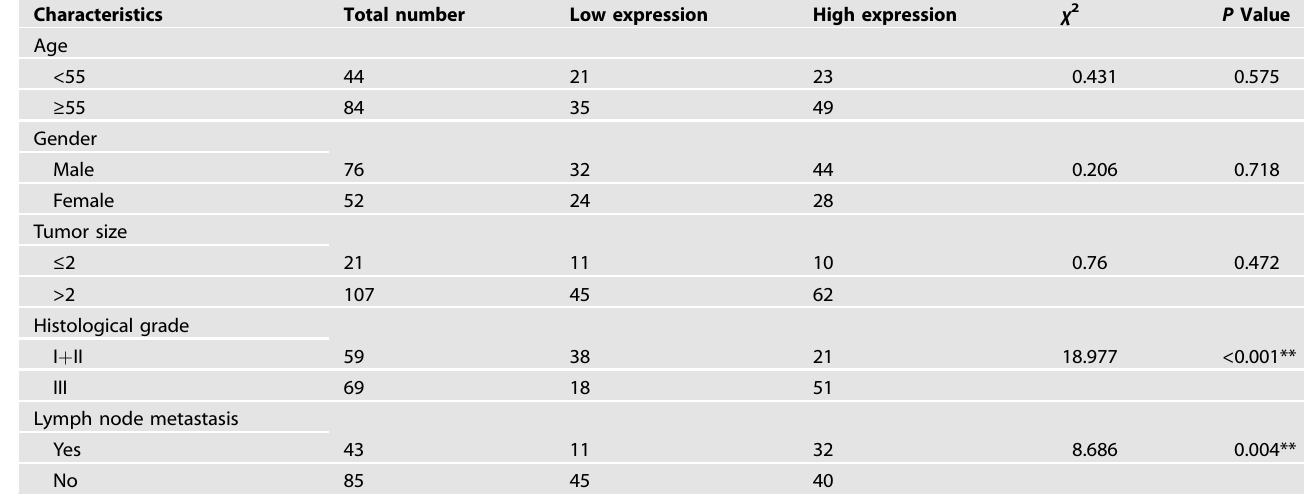
Table 2. Correlation between YAP1 expression and clinicopathological characteristics of PDAC patients ( N = 128).